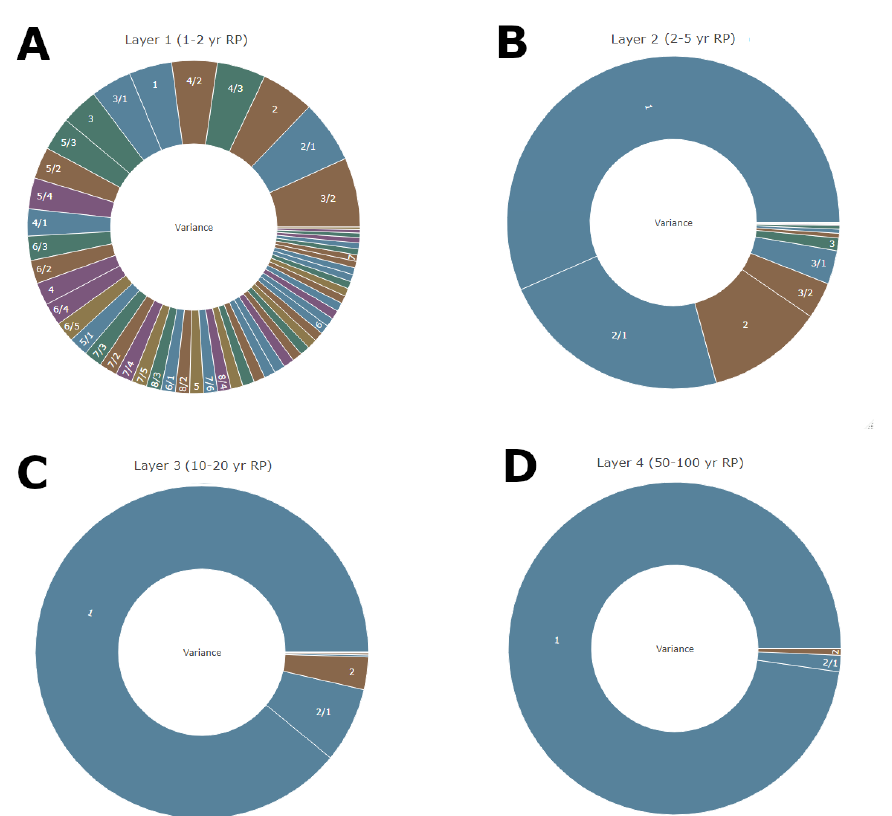
Figure 9. ( Panels A – D ) depict the post-catXL variance decomposition for the multi-peril model. The contribution of any particular marginal or interaction term is proportional to the arc